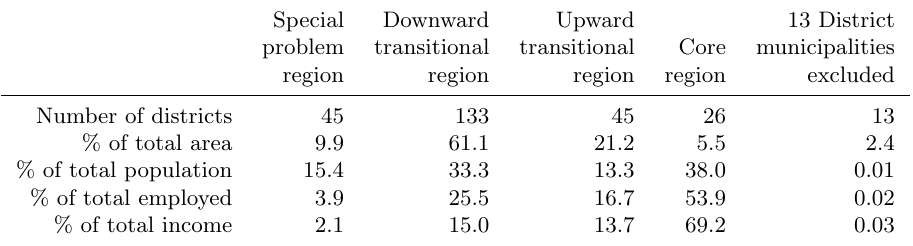
Table 4: Contribution of each regional type to selected variables